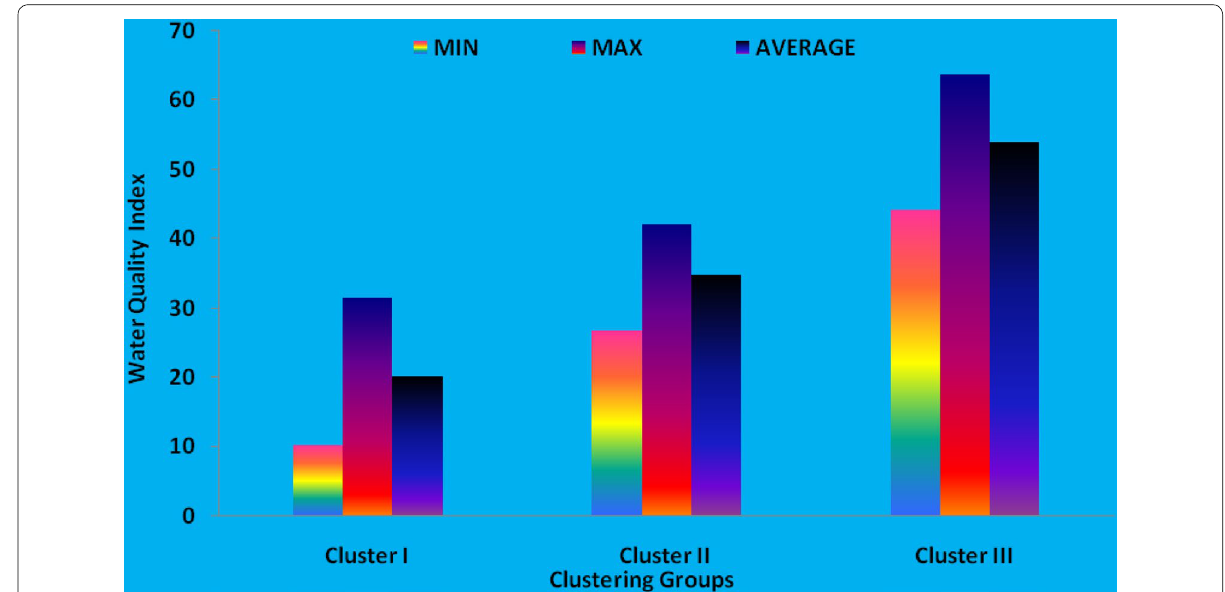
Fig. 10 Comparison of Water Quality Index among the clustering groups with their minimum, maximum, and average values